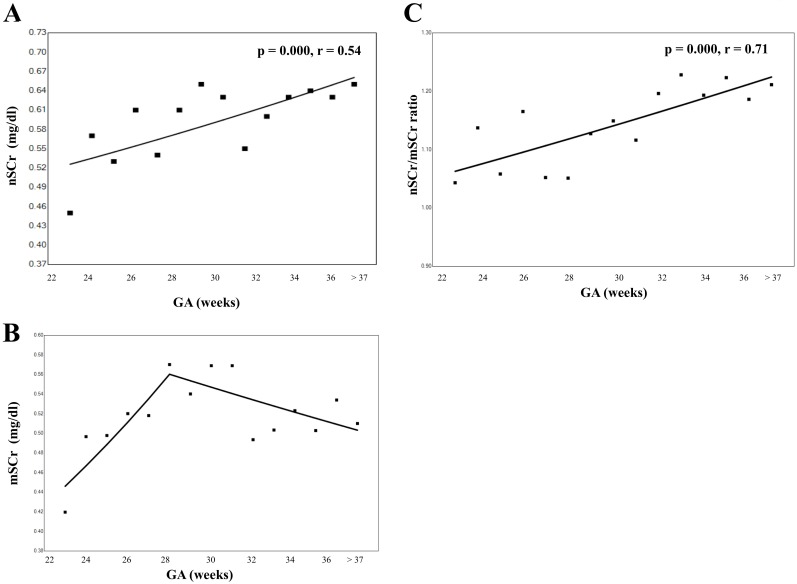
Correlation between nSCr, mSCr and GA.Joinpoint analysis using mean nSCr (A), mSCr (B), and ratio of nSCr/mSCr (C) from 22–41 weeks’ gestational age. Significant correlation between the values of GA, mSCr, and nSCr were analyzed using Spearman’s rank correlation(r) (A, C).